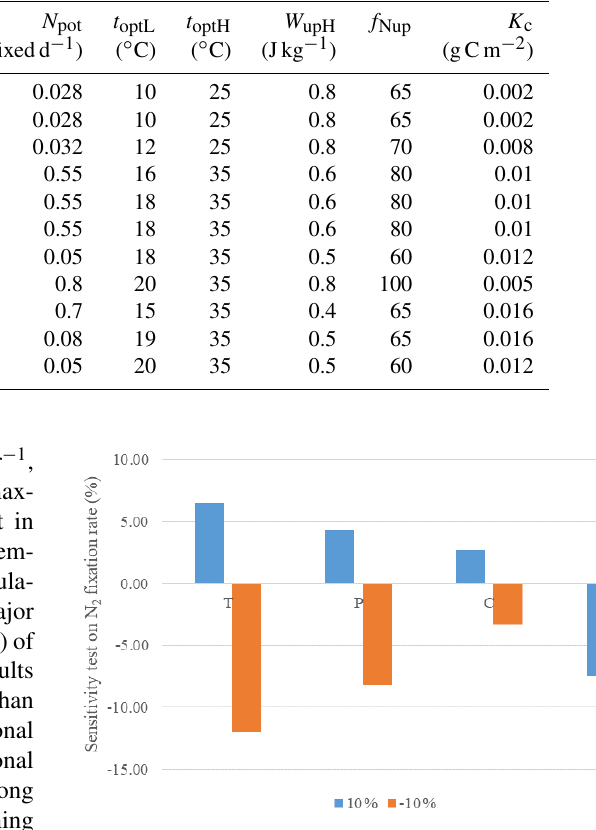
Figure 1. Model sensitivity of N 2 fixation in natural terrestrial ecosystems to changing model input data: increasing or decreasing each variable by 10% for air temperature ( T ), precipitation ( P ), soil carbon content (C) and soil nitrogen content (N) for N 2 fixation